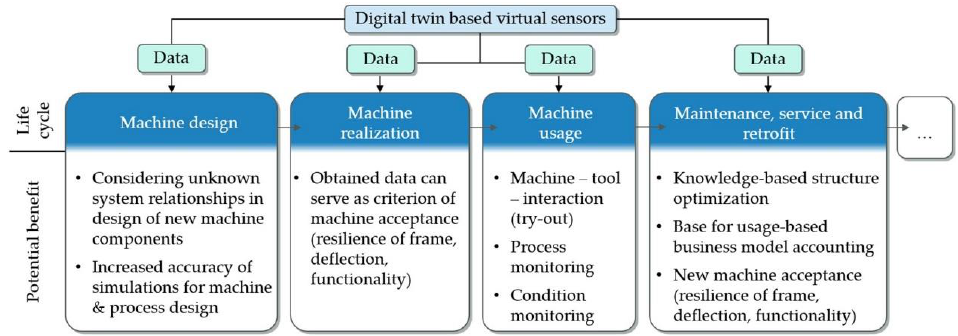
Figure 9. Potential benefits offered by digital twin-based virtual sensors.